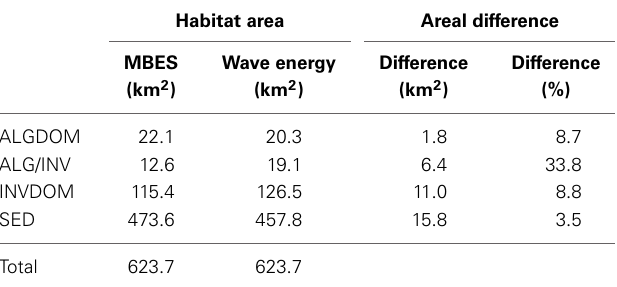
Table 4 | Class area estimations and areal differences derived from the model containing only MBES variables (Acoustic) and the model containing both MBES and wave energy